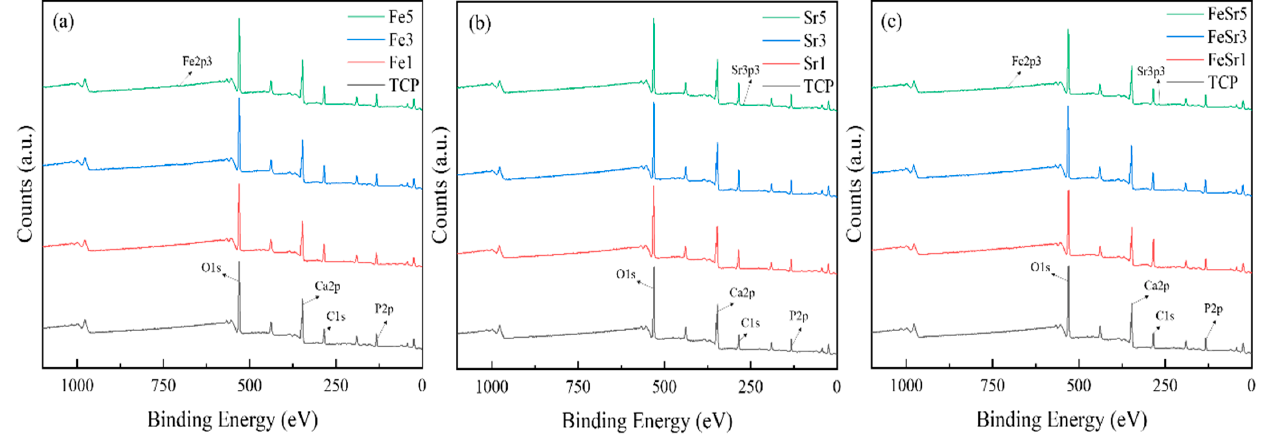
Figure 6. XPS spectra of various β -TCP powders with: ( a ) Fe-substituted samples, ( b ) Sr-substituted samples, ( c ) Fe/Sr co-substituted samples.